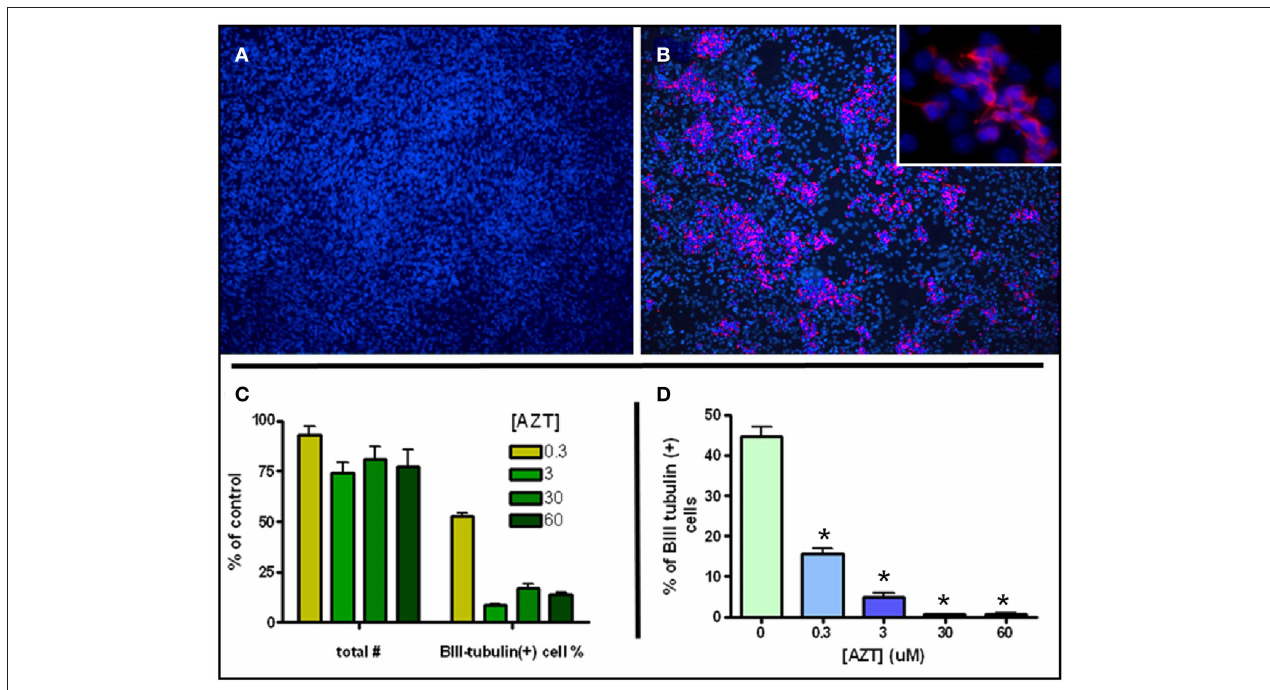
untreated controls (panel C , left four bars). However, treated cultures contain only 10–50% as many β -III tubulin-positive neuroblasts as control cultures (panel C , right four bars). Expressed as a percentage of total cells (D) , neuroblasts in untreated induced cultures comprise about 45% of all cells, while in AZT-treated induced cultures neuroblasts represent from 15% (0.3 µ M) to less than 2% (30 and 60 µ M) of total cells. One-Way ANOVA, Dunnet’s Multiple Comparison Test of significance; N = 3 for all groups; Asterisk indicates values significantly different from untreated controls, ∗ p < 0 . 01 . Error bars represent standard